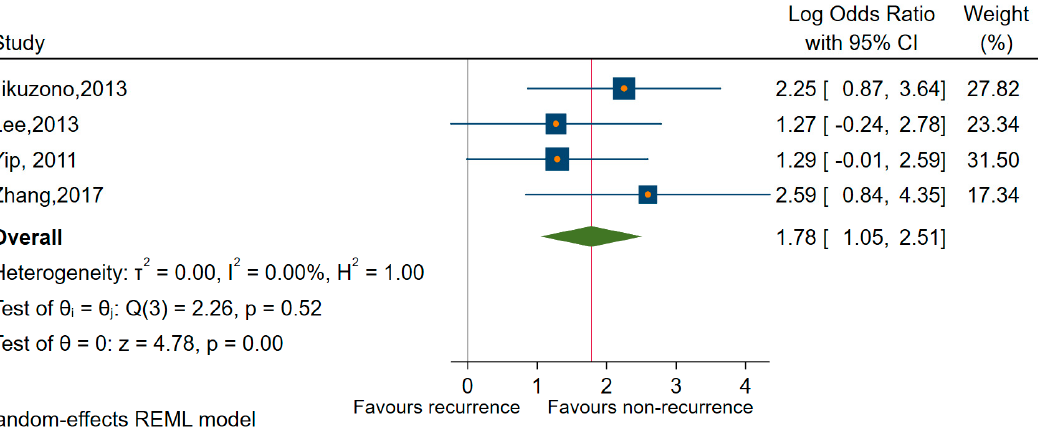
Figure 10. Forrest plot of the association between miR-146b expression and recurrence. Due to insufficient data and a large heterogeneity of outcomes, we could not perform similar analyses about other types of deregulated miRNAs and to determine the association between miR- 146b and miR-221/221 clusters with other outcomes. 3.6.3. Sensitivity Analysis by the Histological Subtypes of TC From the total number of the studies, four studies [64,69,73,76] involving only PTC patients evaluated the association of all upregulated miRNAs with distant and regional recurrence. The analyzed miRNAs (miR-146a, -146b, -155, -193b, -221, -222, and -1299) showed a significant prognostic impact with an OR of 8.40, 95% CI 1.79 to 39.37 (log OR = 2.21, 95% CI 0.58 to 3.67, p < 0.001), and high heterogeneity, I 2 = 80% (95% CI: 0 to 90). Regarding DFS/RFS, studies evaluating the PTC subtype [58,61,74,77] relieved a non-significant association between reported upregulated miRNAs (miR-146b, -203, -220, -221, and -222), ( p > 0.005) and a significant association with the downregulated miRNAs (miR-9, -10b, -21, and -26a), with a pooled HR of 0.65 95%, CI 0.50 to 0.84 (log HR = − 0.42, 95% CI: − 0.67 to − 0.17), and high heterogeneity, I 2 = 68% (95% CI: 0 to 89).